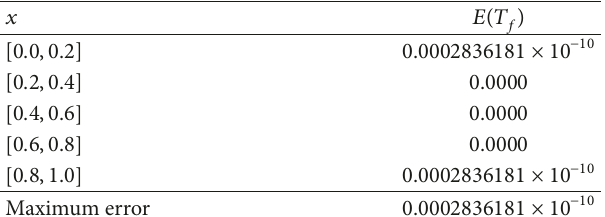
120 100 2580 2060 1540 Figure 6: The Saulyev finite difference solution with quadratic interpolation 𝑐(𝑥,𝑡) (kg/m 3 ) (Δ𝑥 = 0.0500 , Δ𝑡 = 0.0100 , Pe = 5.0) . is used to predict their initial and boundary conditions